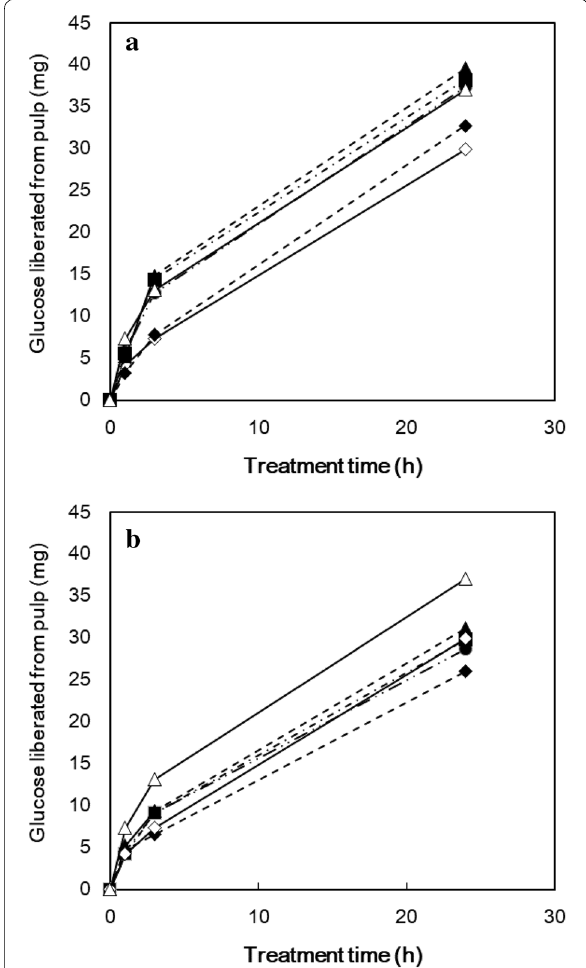
Fig. 5 Enzymatic saccharification of beaten pulp with enzyme at 3.2 FPU/g: a larch SP with the kappa number 74.6 and b acacia SP with the kappa number 52.3. Solid diamond, solid circle, solid square and solid triangle: the number of PFI revolutions 0, 2500, 5000, and 7500, respectively, and open diamond, open triangle: filter paper, PFI revolutions 0 and 7500, respectively. Enzymatic treatment: pulp 50 mg, acetate buffer pH 4.5 and 1.5 mL and temperature at 45 °C